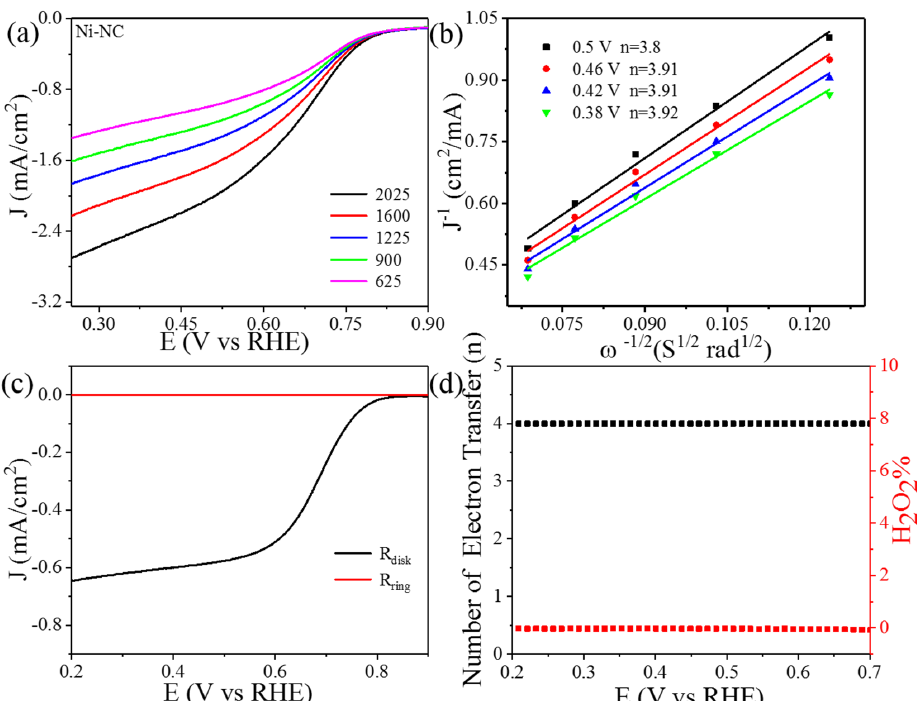
Figure 6. RDE tests ( a ) and corresponding K-L lines ( b ) of Ni-NC in oxygen saturated 0.1 M KOH at various rotation speeds with the sweeping rate of 0.005 V s − 1 . RRDE test ( c ) and the corresponding electron transfer numbers ( n ) and H 2 O 2 % ( d ) of Ni-NC at 1600 rpm with the same sweeping rate.